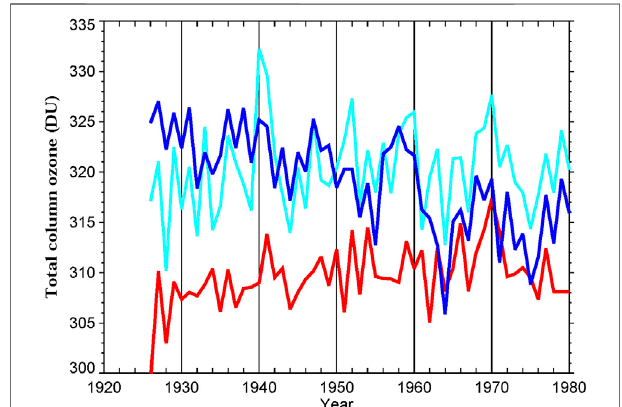
FIGURE 8 | Evolution of the northern hemisphere mean TCO obtained from the HISTOZ data set (red line) and retrieved from proxies without (blue line) and with Arosa/Davos TCO as an additional proxy (light blue line). The correlation coef fi cients with HISTOZ data are − 0.13 and 0.49 for the cases without and with Arosa/Davos